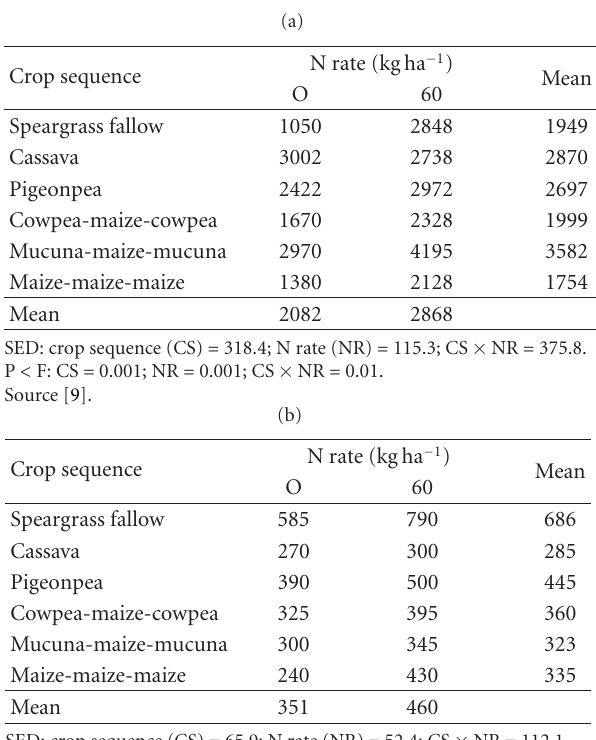
Table 2: E ff ect of crop sequence and N rate on (a) maize grain yield (kgha − 1 ) and (b) weed biomass (kgha − 1 ) associated with the maize crop at 8 weeks after planting on researcher-managed plots.